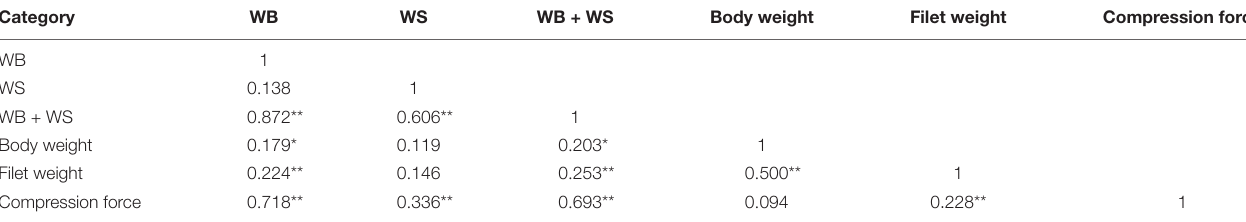
TABLE 3 | Spearman’s correlation coefficients between WB and WS scores, bodyweight, filet weight and compression force in flock 1. Category WB WS WB + WS Body weight Filet weight Compression force